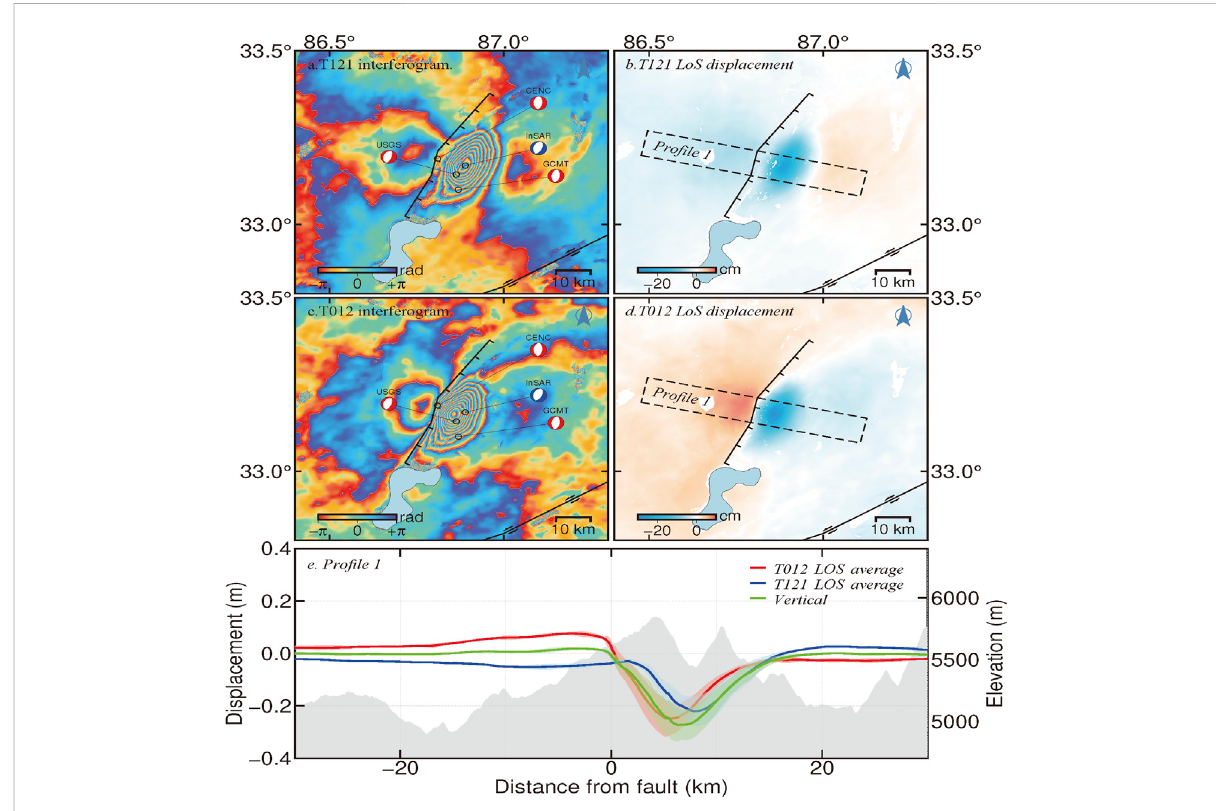
FIGURE 5 Coseismic LoS deformation of T012A and T121D for the 2020 Nima earthquake. The red, blue, and green solid lines and shadows in Panel e indicatecoseismicLoSdisplacementsofT012AandT121Dandcoseismicverticaldisplacementsforthe2020NimaearthquakeofPro fi le1inPanelb.